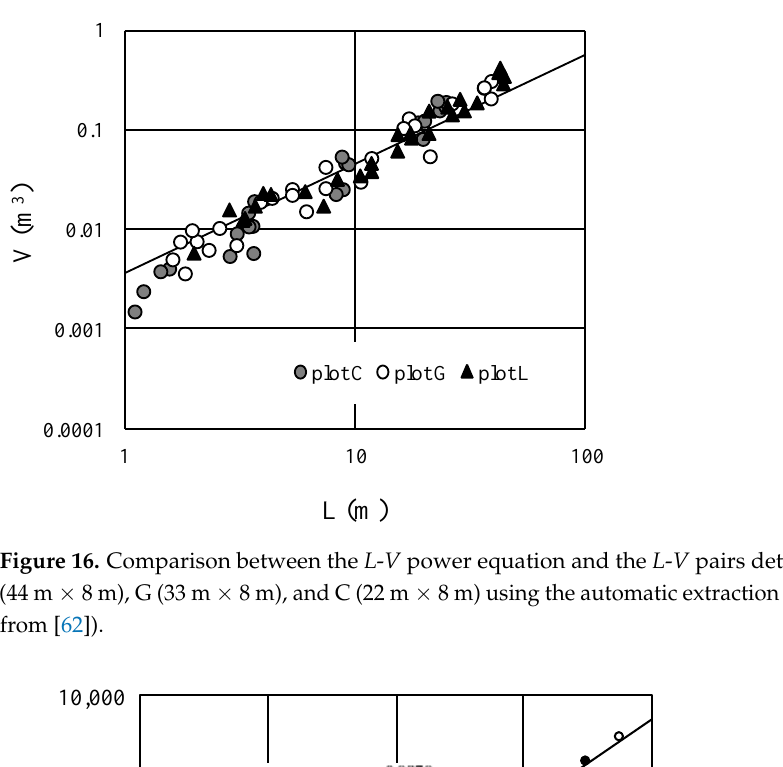
Figure 18. Effect of plot steepness s on drainage density D k for contributing and non-contributing rills (modified from [67]). A further analysis aimed to compare the amount of sediment stored in the tank with the rill component due to contributing rills. When considering the former as a reference value (DM, Figure 19), soil loss measurement error by the 3D model was equal to 6% (TS) and −6% (UAV) for the 26% sloping plot and equal to 13% (TS), −8% (UAV), and 10% (UAV + TS) for the 22% sloping plot (Figure 19). In any case, these errors were within the